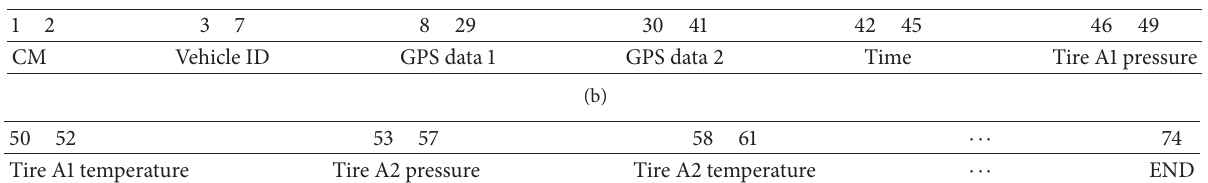
Table 3: Frame Format of Frame’s Header is